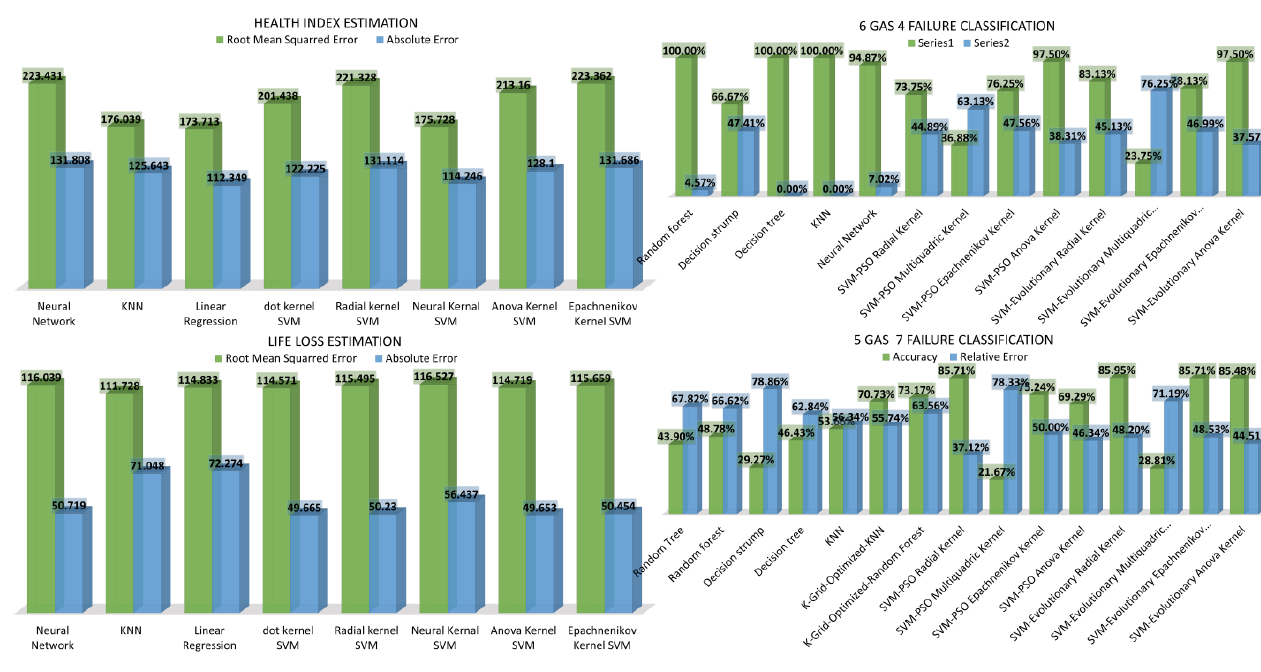
Figure 14. Tested algorithms results summary.